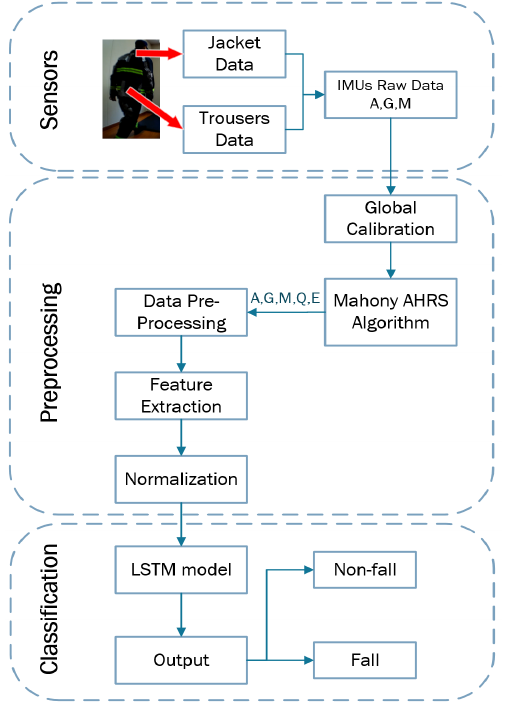
Figure 9. Flowchart of the FDS algorithm, where A = triaxial accelerometer data, G = triaxial gyroscope data, M = triaxial magnetometer data, Q = quaternion data, and E = Euler angles.